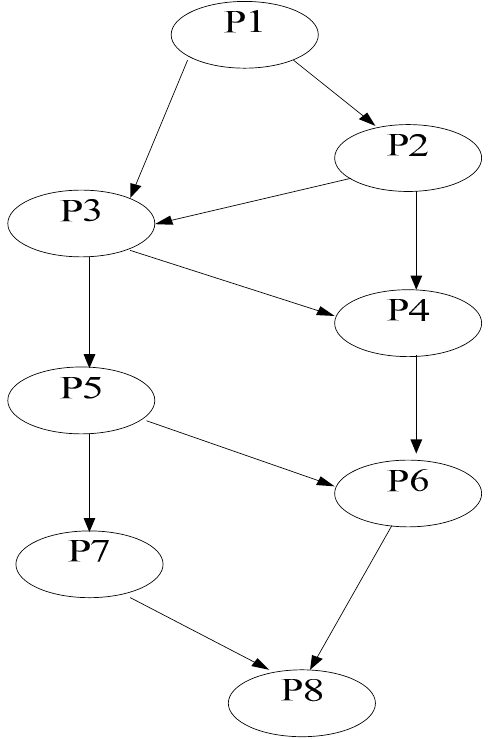
Figure 2. Bayesian network structure diagram.